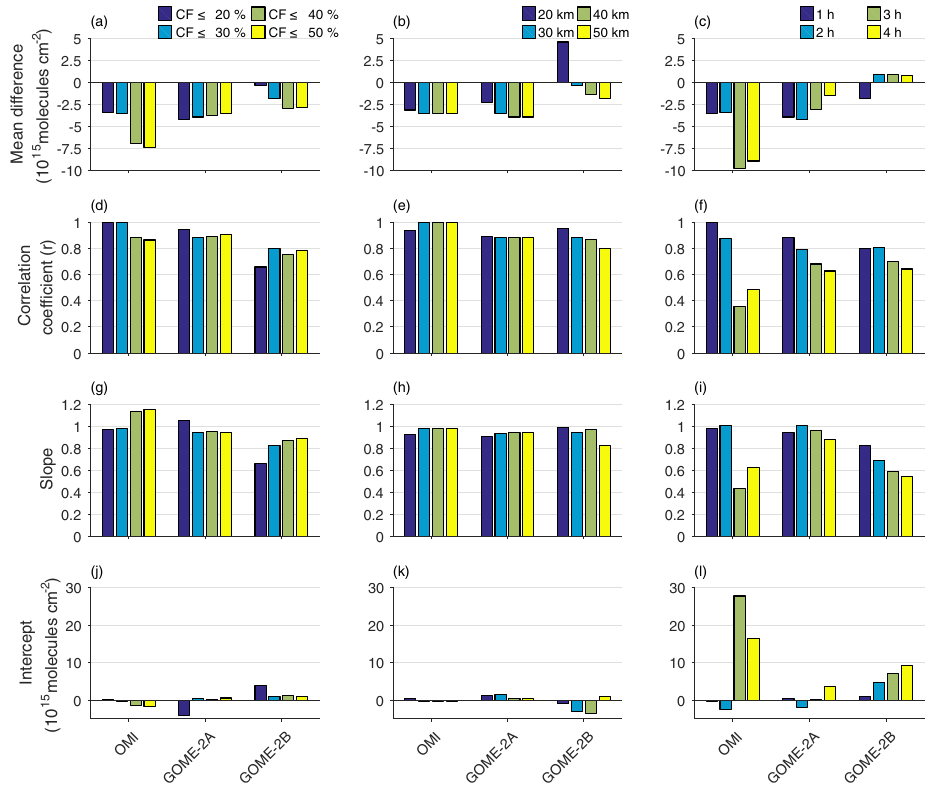
Figure 9. Bar plots of the statistical results of the comparisons between ground-based and satellite tropospheric NO 2 data pairs for the dif- ferent coincidence criteria used in this study: cloud fraction (a, d, g, j) , distance of satellite pixel center from the ground-based measurement location (b, e, h, k ) and time window around satellite overpass (c, f, i, l) . The mean difference (a, b, c) refers to the absolute difference of the satellite-derived tropospheric NO 2 from the MAX-DOAS observations. All the statistics are presented in Table